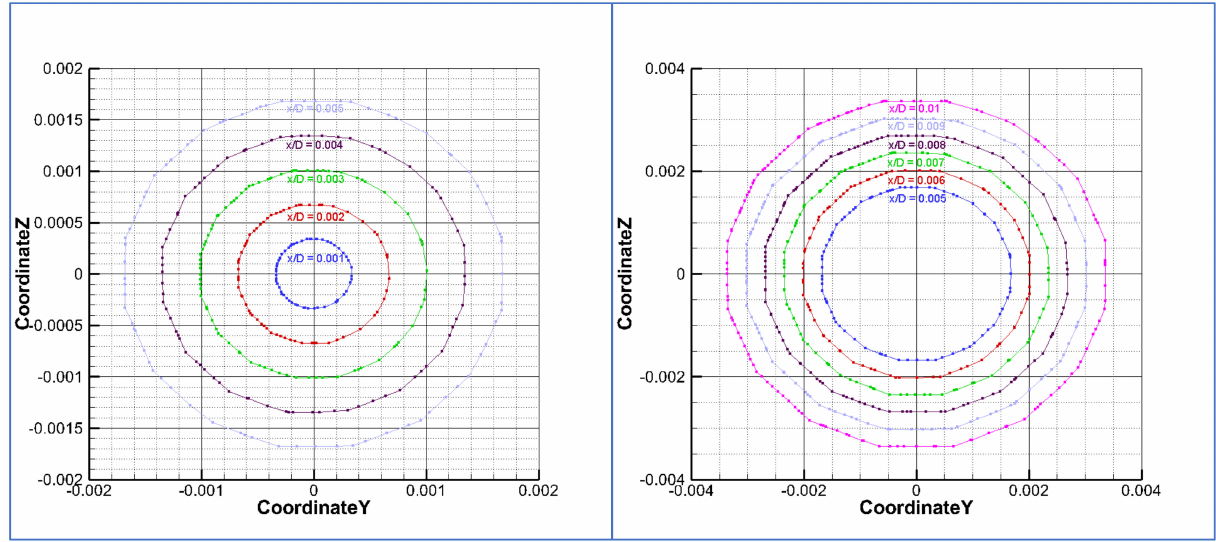
Figure 5. ( Left ) surface mesh cross sections at x/D = 0.001 to x/D = 0.005. ( Right ) surface mesh cross sections at x/D = 0.005 to x/D = 0.010. Finer unstructured grid (Grid